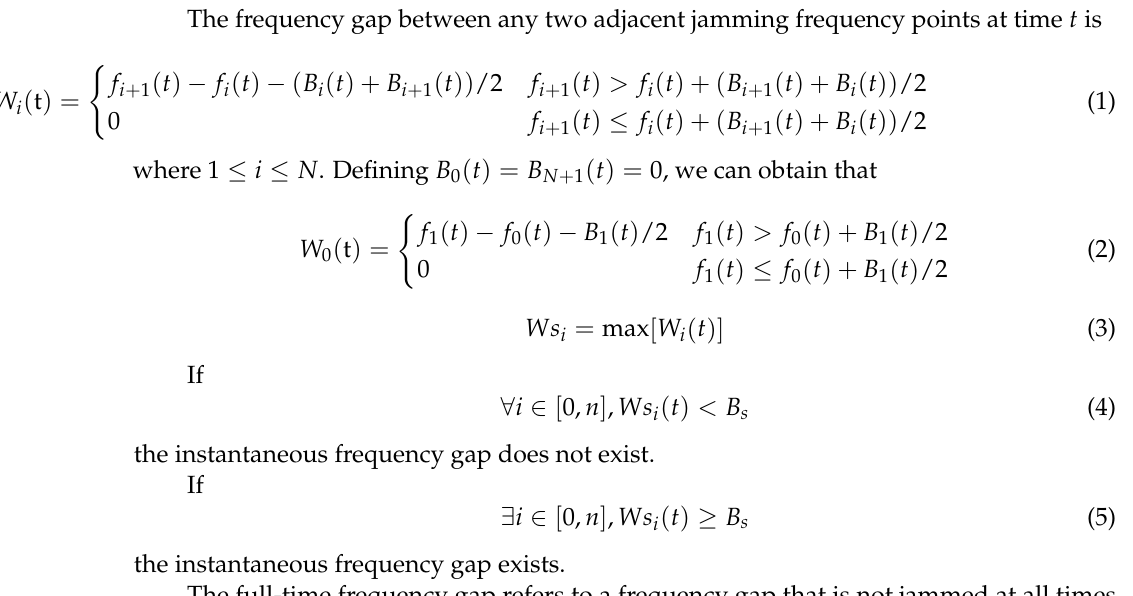
Figure 3. Frequency domain representation of the jamming signals.